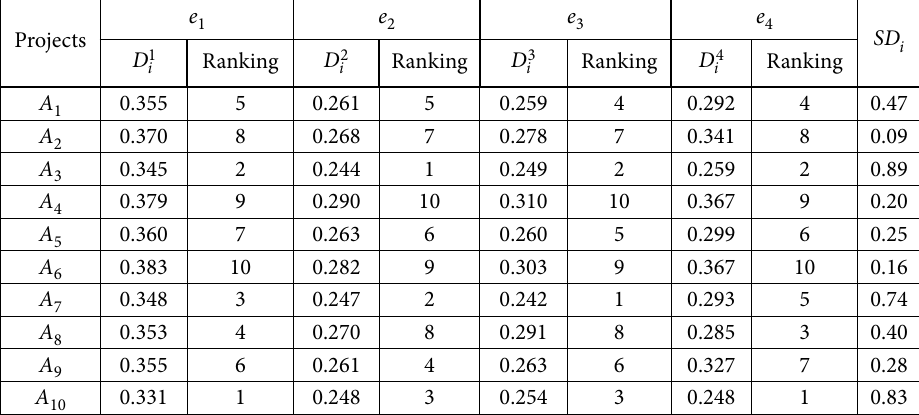
Table 7. The ranking of projects for each expert and the group support degrees of projects Projects